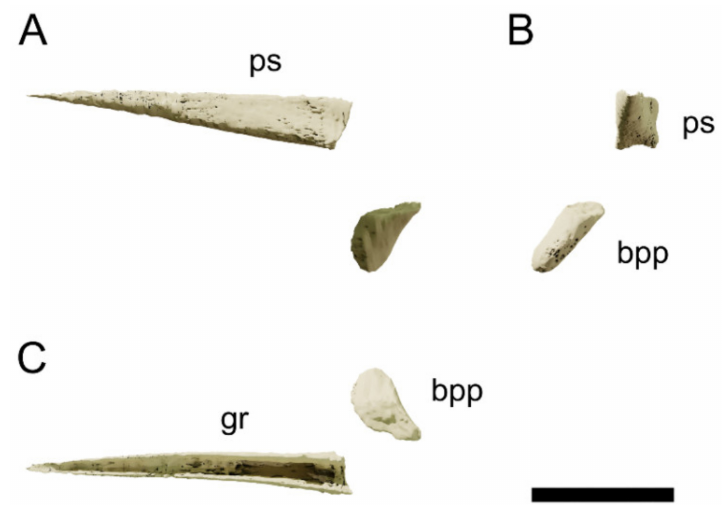
Figure 24. Digital reconstruction of the basisphenoid of NHMD 164758. ( A ) Lateral view. ( B ) Anterior view. ( C ) Dorsal view. The elements were articulated digitally for the reconstruction. Abbreviations: bpp, basipterygoid process; gr, groove; ps, parasphenoid. Scale bar = 20 mm.